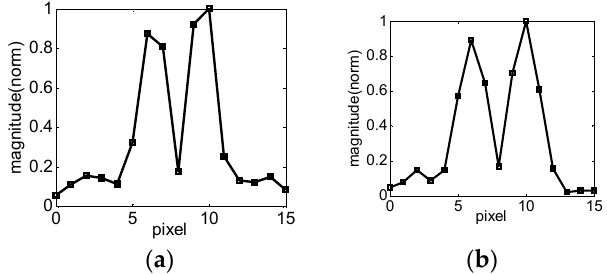
Figure 6. 1D images obtained in the x - and y -directions. A simple object made up of two natural rubber strips was imaged. The rubber strips were 2.5 mm wide and separated by 3 mm. The k space was sampled with the gradient amplitude increasing from negative to positive values, and the total steps were 11. The k space was zero filled up to 16 points before Fourier transformation. ( a ) 1D image obtained after orienting the object structure in the x -direction. Approximately 10 mm field of view (FoV) was obtained using a gradient pulse length of 270 μ s, maximum amplifier current of 4.7 A, and G x,max = 45 mT/m. ( b ) 1D image of the object structure in the y -direction. Approximately 10 mm FoV was obtained using a gradient pulse length of 270 μ s, a maximum amplifier current of 6.7 A, and a G y,max of 45 mT/m.